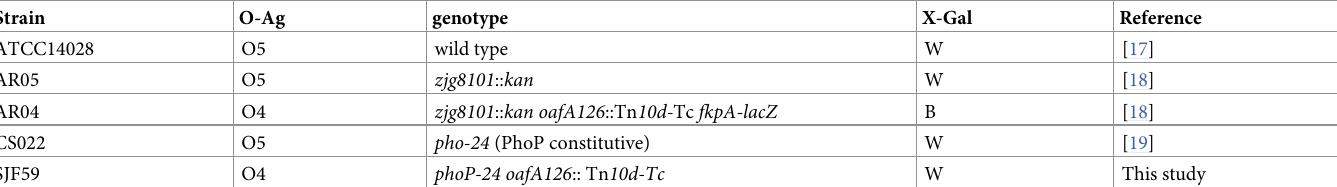
Table 1. ST strains and derivatives used in this study. Strain